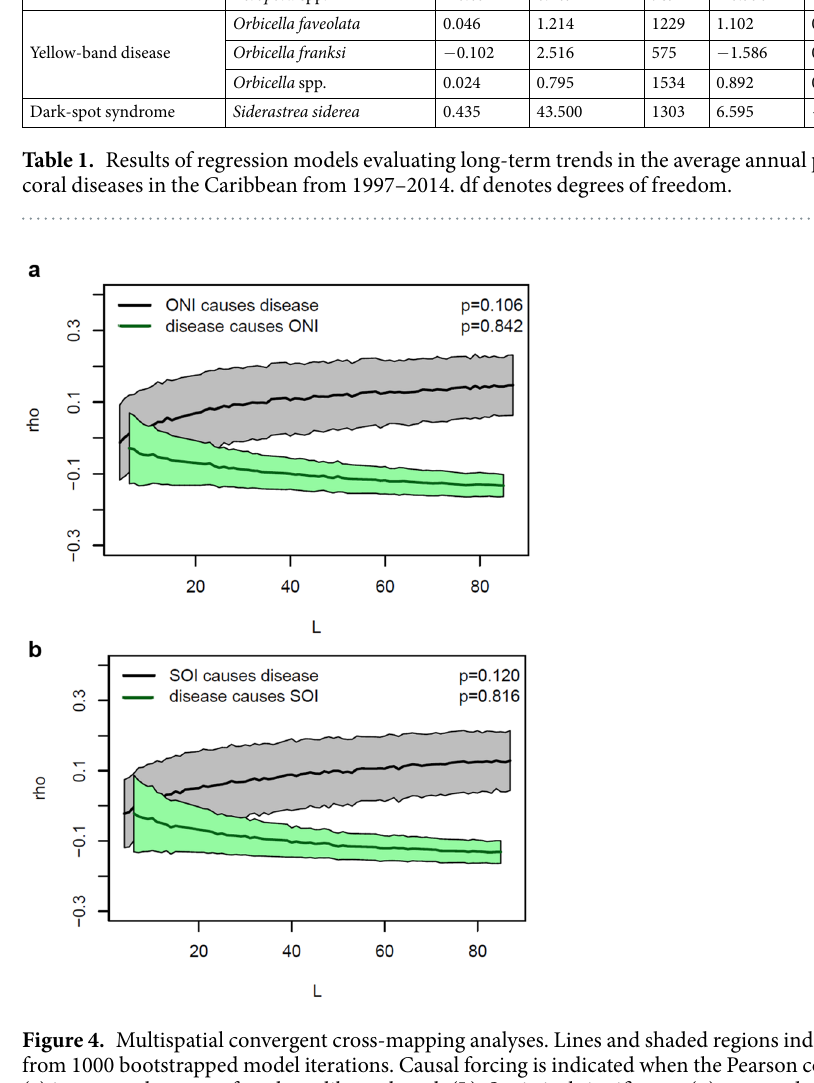
We hypothesize that these ecological changes, combined with increasing background sea-surface temperatures and short-term climate cycles have led to the present state of low background levels of disease punctuated with dynamic outbreaks. The significant coupling of coral-disease cycles with ENSO cycles, identified in this study, suggests that multi-year fluctuations in climate-driven environmental conditions influence the contemporary patterns of coral diseases in the Caribbean. When all three diseases, on all five host species, were considered together, convergent cross-mapping (CCM) analyses indicated that conditions associated with the ONI and the SOI are likely drivers of the disease (Fig. 4). Despite the inherent variability in the prevalence data, and the small sample size of replicated time series, the CCM models consistently indicated that there was less than a 10% chance of obtaining the observed data, if no real causal effect existed (Fig. 4). The identification of large-scale climatic drivers of disease is not without prece- dent however. In terrestrial environments, the vector-borne protozoal disease cutaneous leishmaniasis peaks sea- sonally, but also cycles with a periodicity of 3.2 years in association with ENSO cycles 23 . Similarly, many tropical mosquito-borne diseases, including dengue fever 24 and malaria 25 , synchronize with ENSO. This synchrony results from increasing temperatures and increasing rainfall during El Niño years, both of which increase mosquito pop- ulations, and consequently increase the rate of infectivity in human populations.